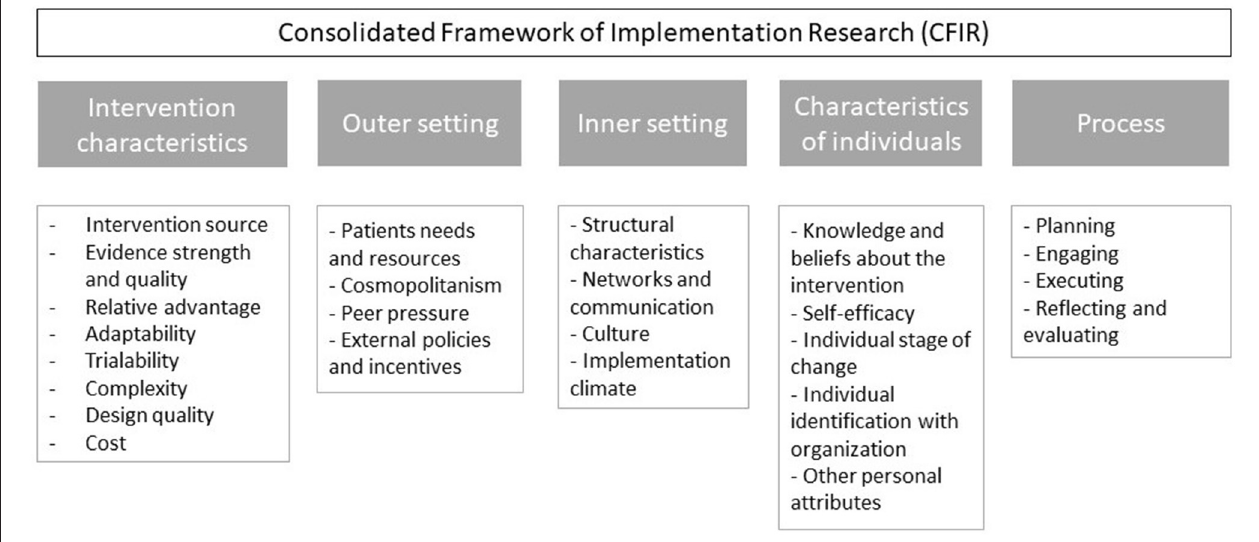
FIGURE 2 | Overview of the consolidated framework for implementation research.